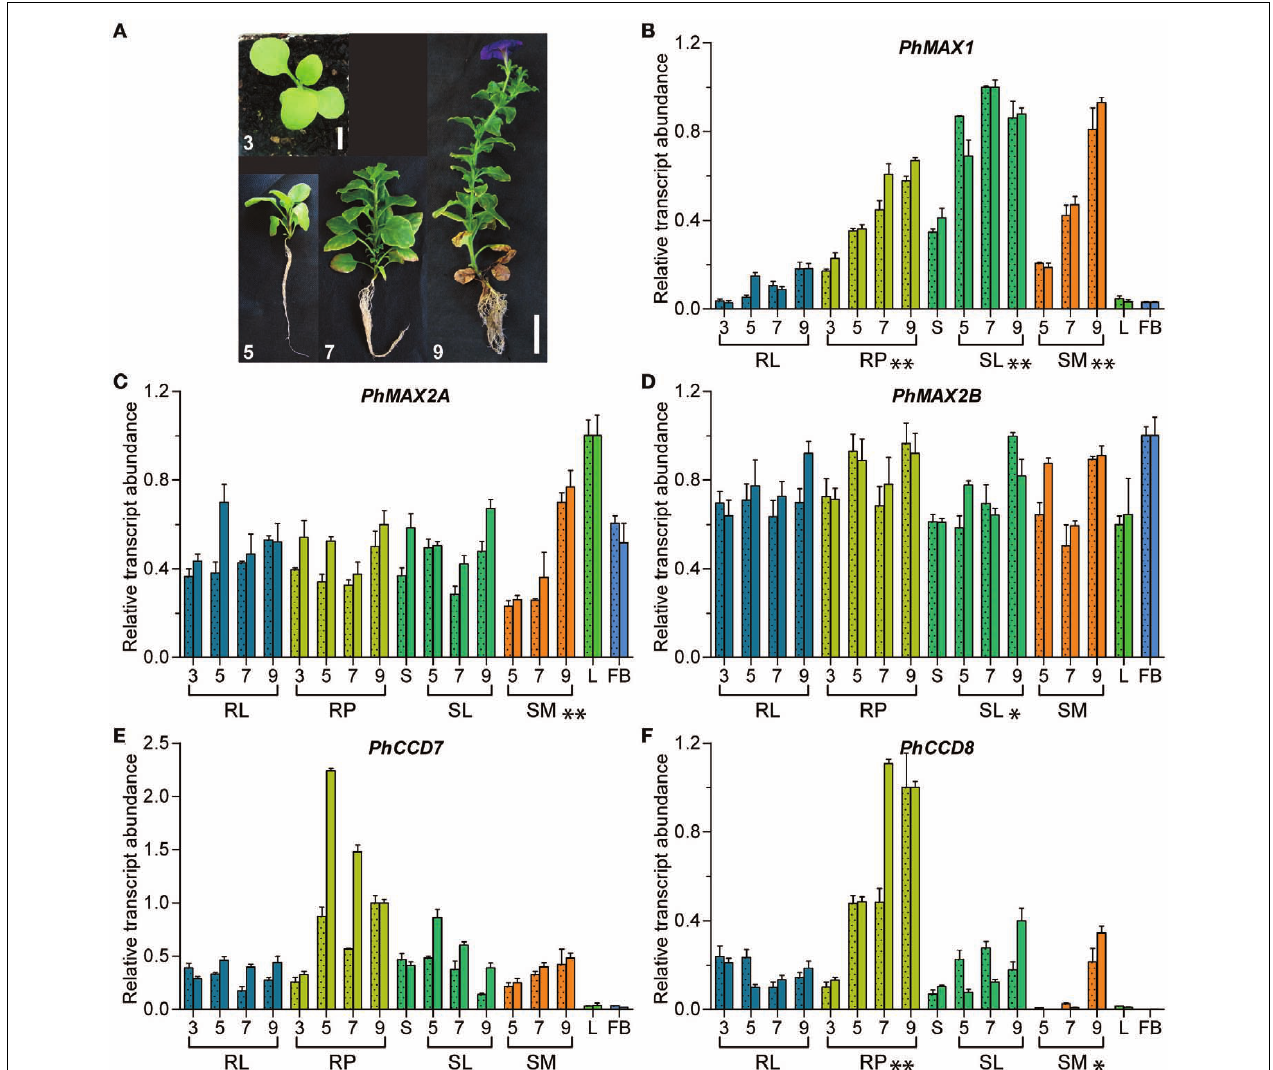
2cm of stem above node eight; L, leaves 2–4; FB, flower buds less than 5mm in length. Changes in transcript abundance for each sample type over time were significant at P < 0.01 (**) or P < 0.05 (*) as indicated (the S sample was grouped with the other SL samples for this analysis). Relative transcript abundance as rescaled against the sample with the greatest expression in replicate one for each gene (B) PhMAX1 , (C) PhMAX2A , (D) PhMAX2B , (E) PhCCD7 , (F) PhCCD8